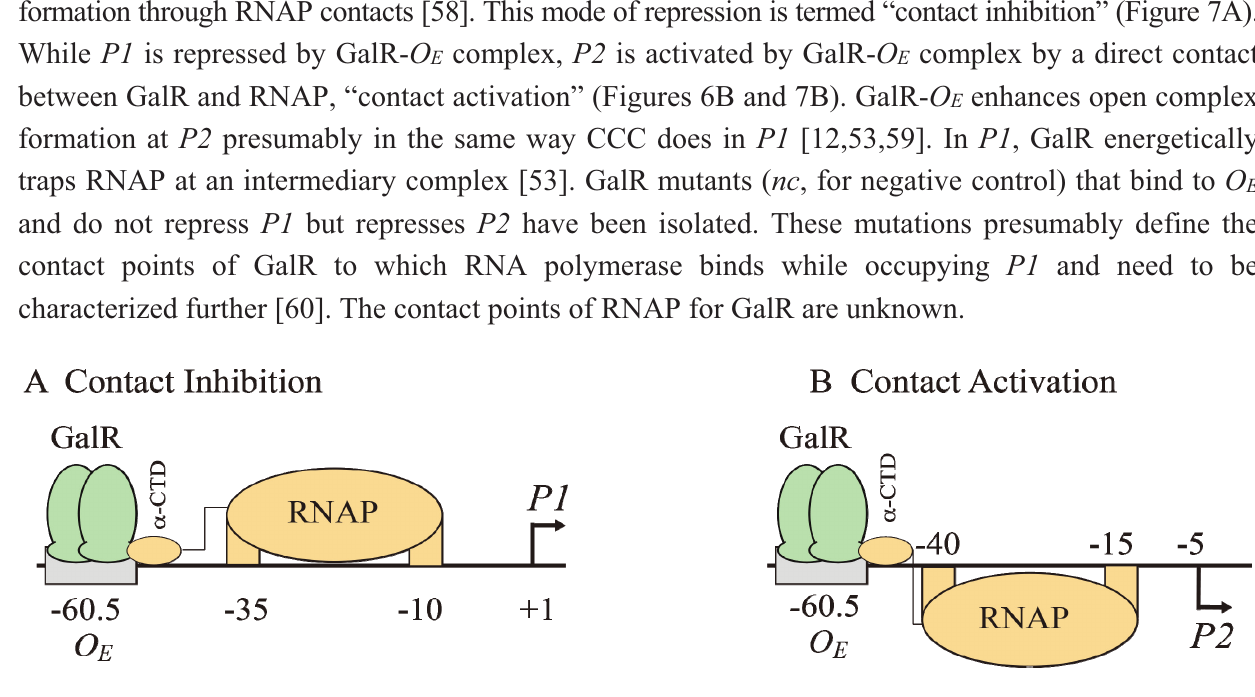
Figure 7. Models of GalR-RNAP contacts. ( A ) Contact inhibition of P1 : GalR (light green) at O E is interacting with the (cid:3)-CTD of RNAP (brown) at the (cid:2)10 and (cid:2)35 elements of P1 ; ( B ) Contact activation of P2 with the (cid:3)-CTD of RNAP at the (cid:2)10 and (cid:2)35 elements of P2